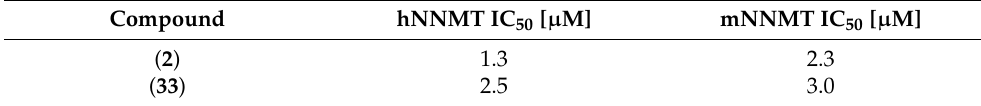
Table 4. hNNMT and mNNMT enzymatic activity of inhibitors ( 2 ) and ( 33